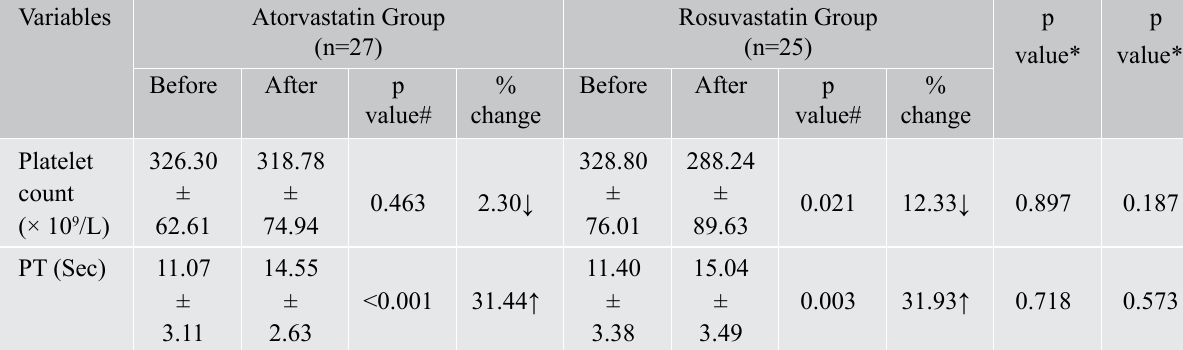
Table II: Thrombogenic biomarkers at baseline and after intervention